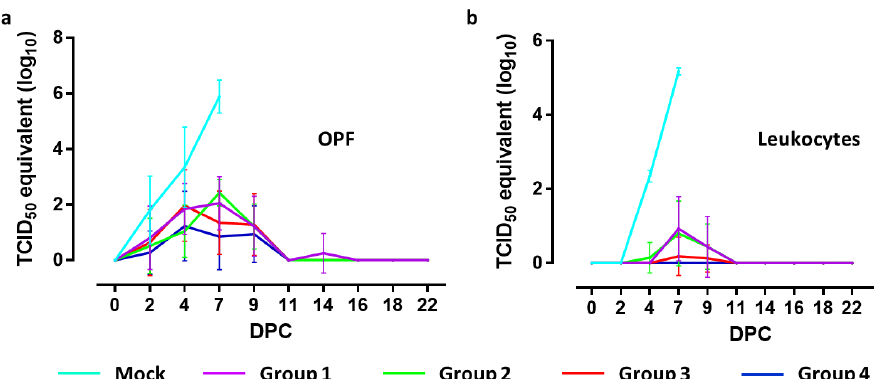
Figure 3. Detection and quantification of CSFV-specific RNA in OPF samples and leukocytes collected from vaccinated and mock-vaccinated pigs after challenge infection. Graphs depict means of viral RNA levels, as log 10 TCID 50 / mL , detected in OPF samples ( a ) or isolated leukocytes ( b ). Error bars represent SD.